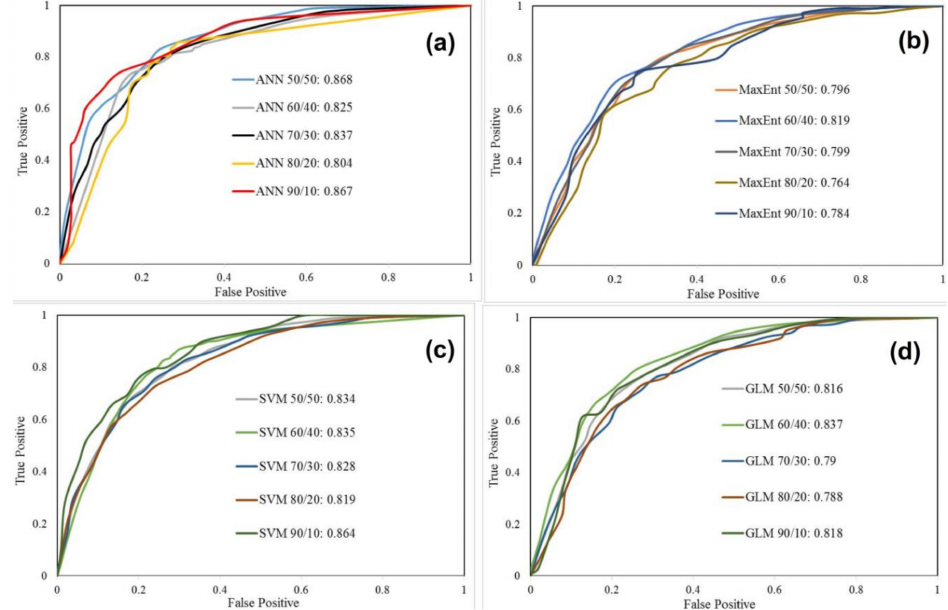
Figure 12. Area under the curve based on validation datasets in the ANN ( a ), MaxEnt ( b ), SVM ( c ), and GLM ( d )